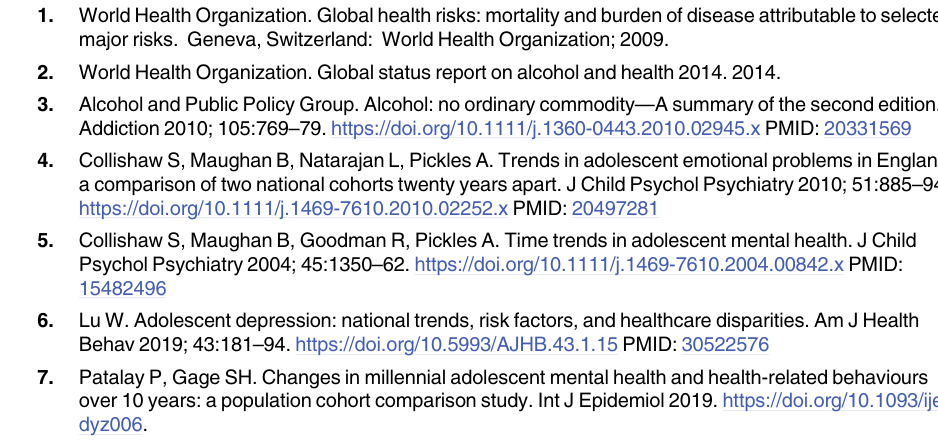
S2 Fig. Distribution of P-value between INT and phenotype of alcohol use behaviours. (TIF) S3 Fig. Distribution of P-value between Depression and phenotype of alcohol use behav- iours. (TIF) S4 Fig. Distribution of P-value between Anxiety and phenotype of alcohol use behaviours. (TIF) S1 Text. Details on exposure and outcome of 36 included articles.